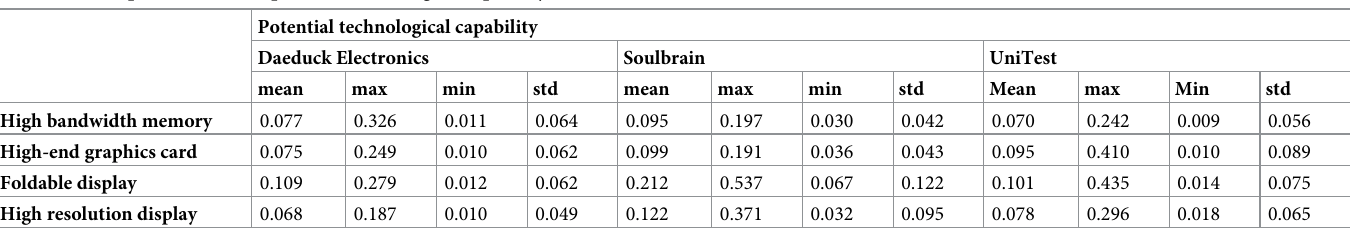
Table 7. Descriptive statistics of potential technological capability.